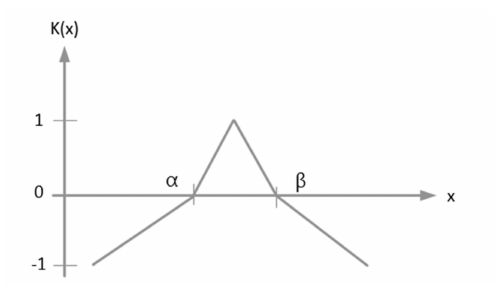
Figure 4. Extension